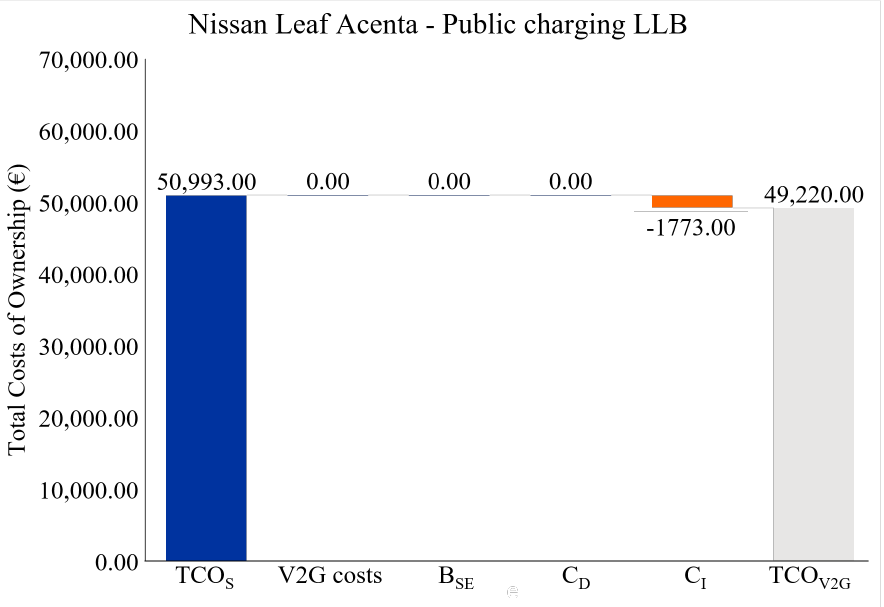
Figure 10. Standard and V2G TCO of a Nissan Leaf in a semi-public charging case providing IS ( TCO S = Standard TCO, B SE = benefit of saved electricity costs from the grid, C D = direct compensa- tion, C I = indirect compensation, TCO V 2 G = V2G TCO); source: own compilation).